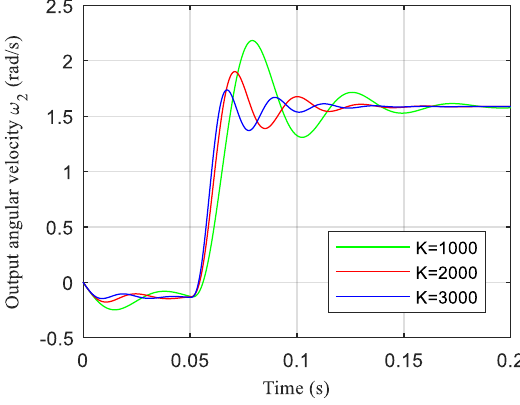
Figure 15. The response curve of the output angular velocity.